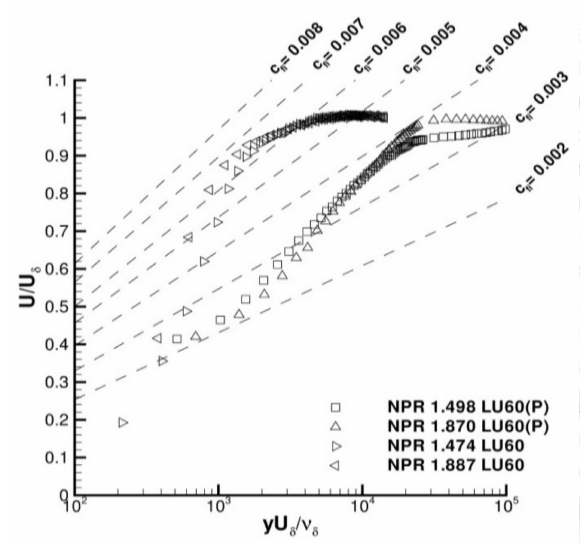
Figure 15. LU60 and LI60P nozzle exit Clauser plots.